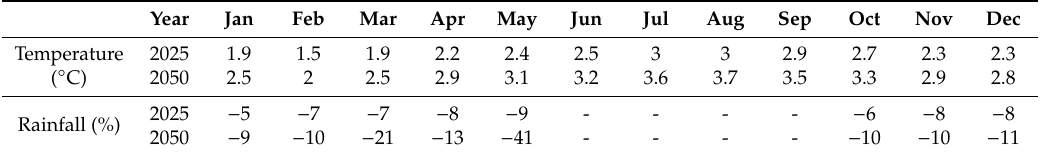
Table 3. Average monthly temperature ( ◦ C) and average monthly rainfall (%) based on UKMO for 2025 and 2050 compared to the long-term average in